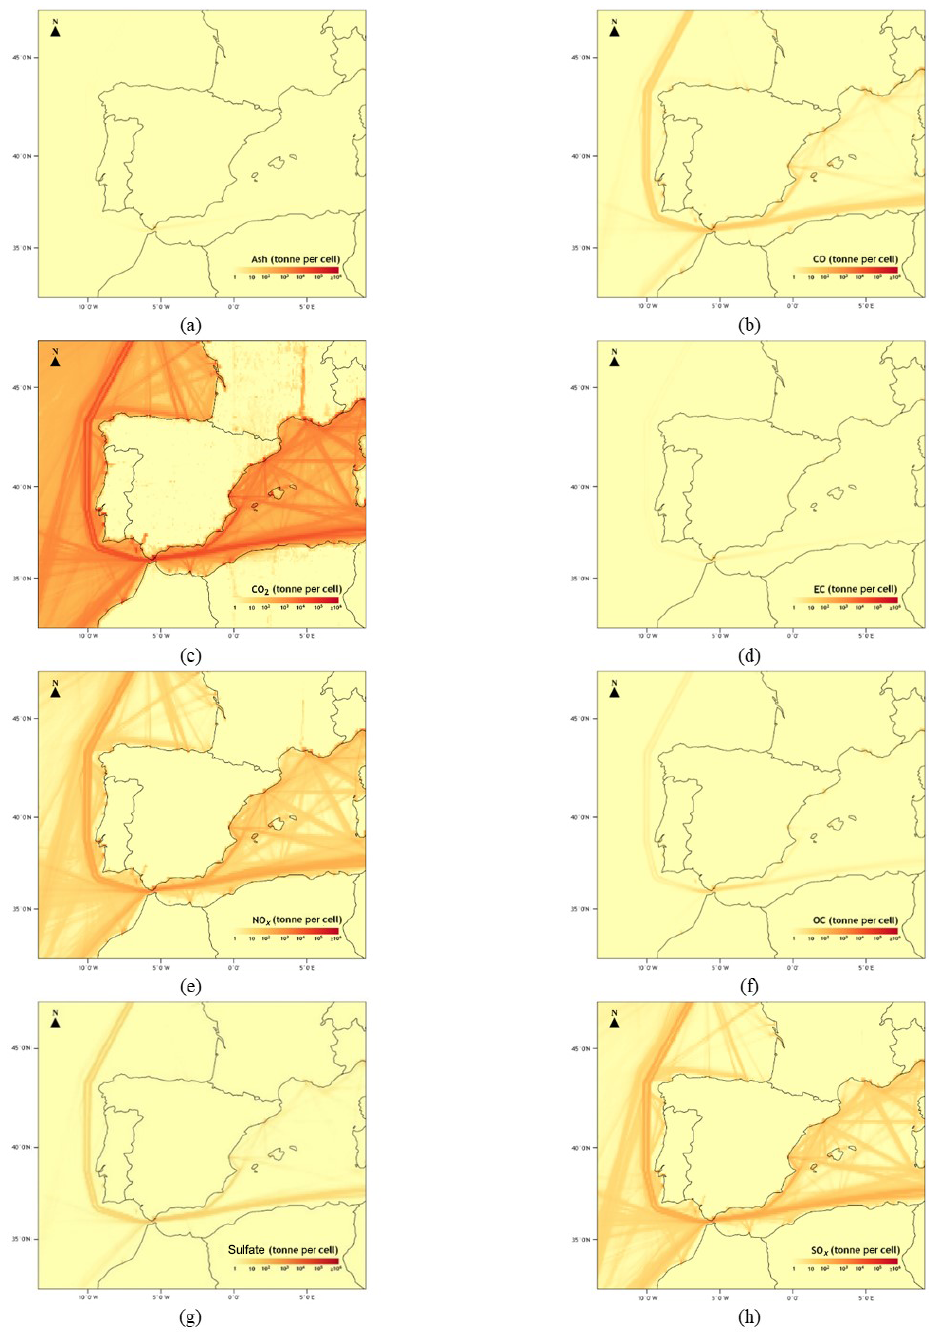
Figure 1. Shipping emissions of (a) ash, (b) CO, (c) CO 2 , (d) EC, (e) NO x , (f) OC, (g) sulfate, and (h) SO x in the study domain for